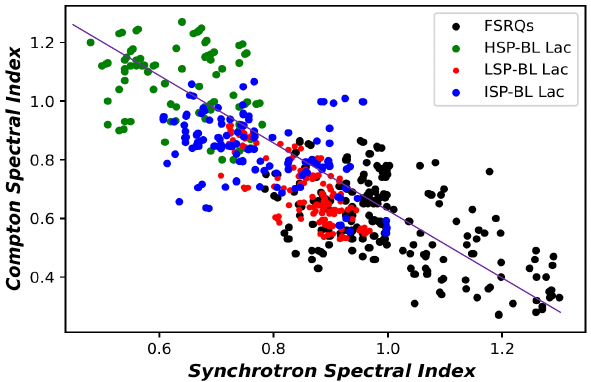
Figure 4. Scatter plot of α com − α syn for FSRQs and BL Lac